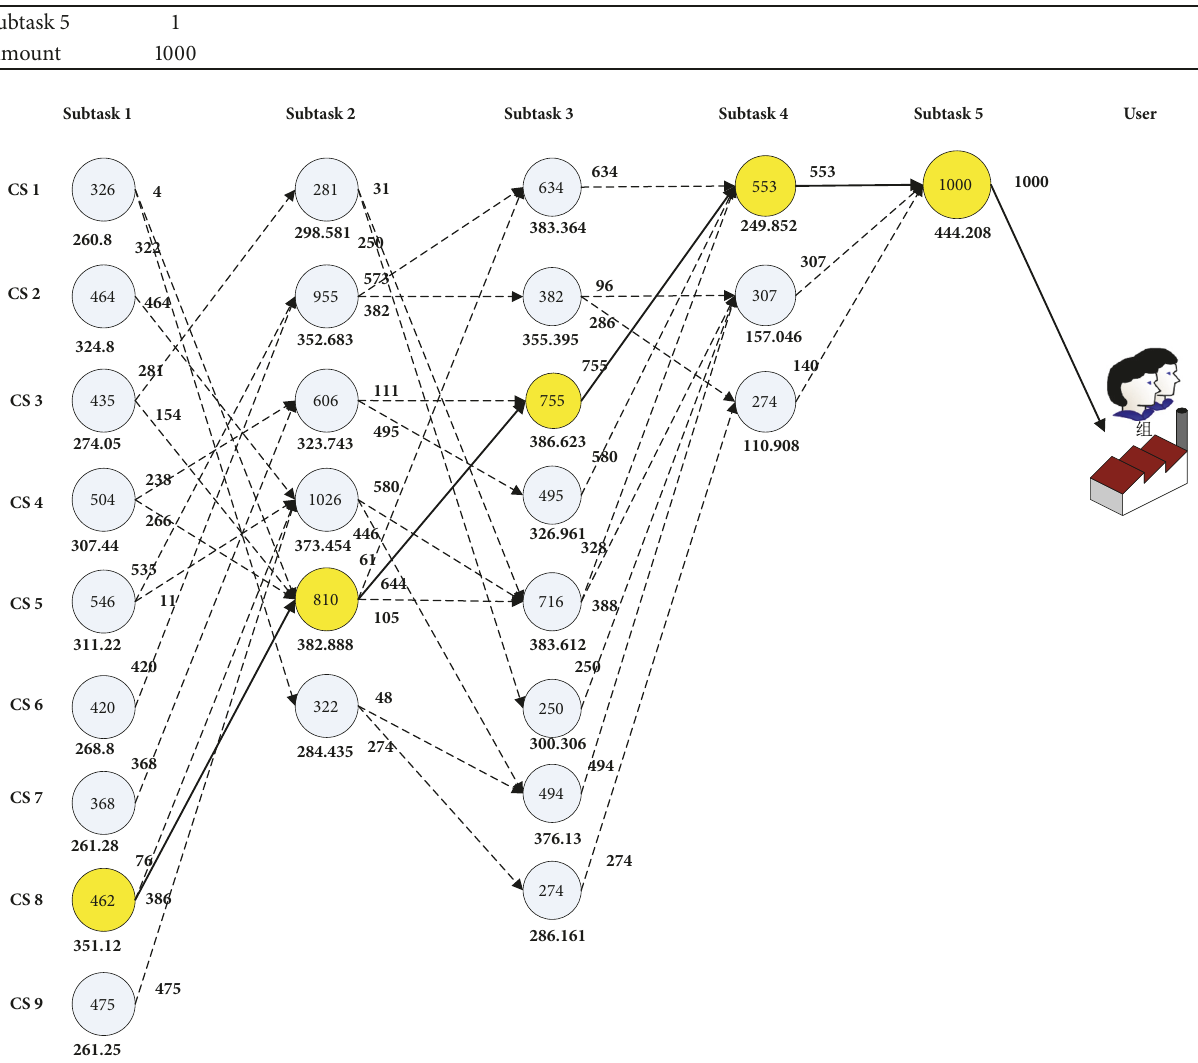
Figure 5: Schematic of the best